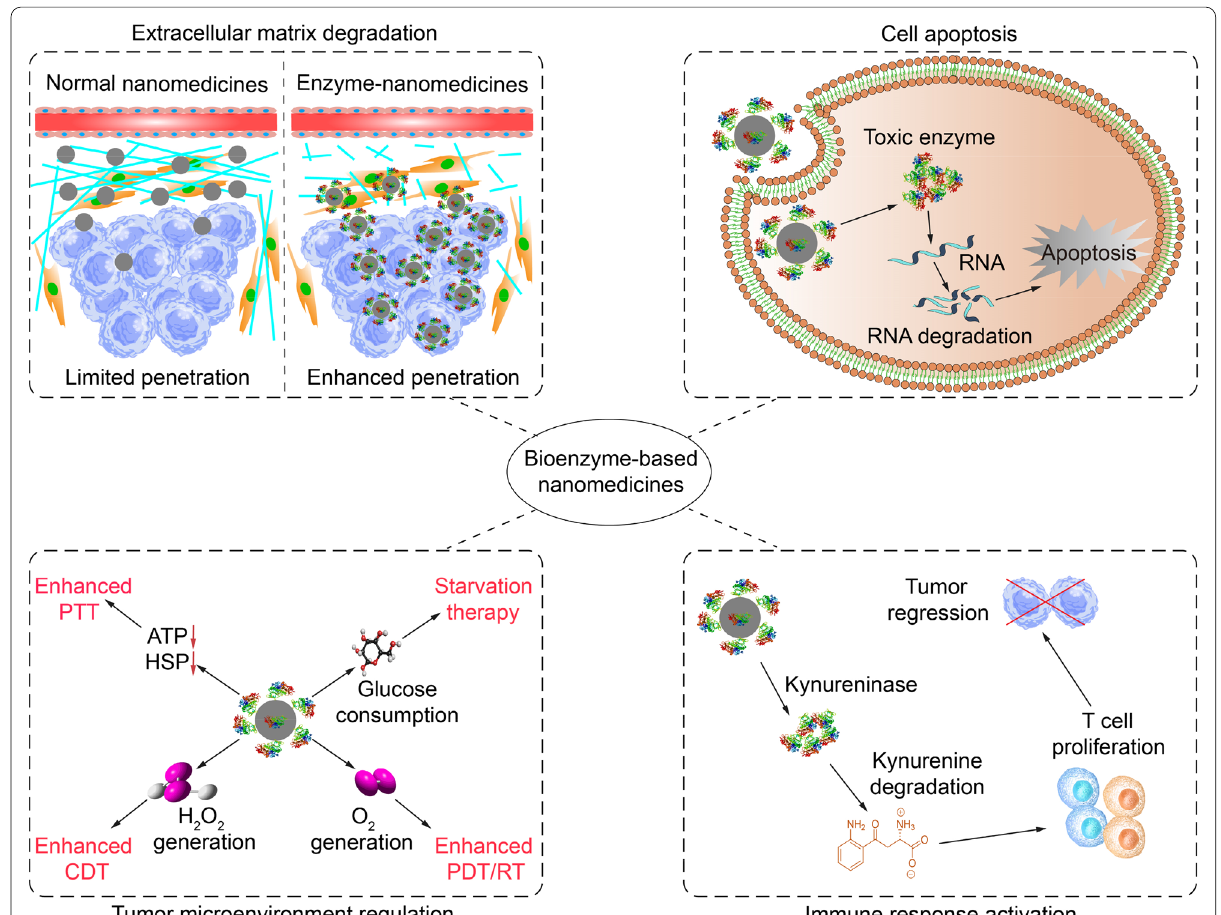
Fig. 1 Summary of bioenzyme-based nanomedicines for enhanced cancer therapy via degradation of extracellular matrix, induction of cell apoptosis, regulation of tumor microenvironment, and activation of immune